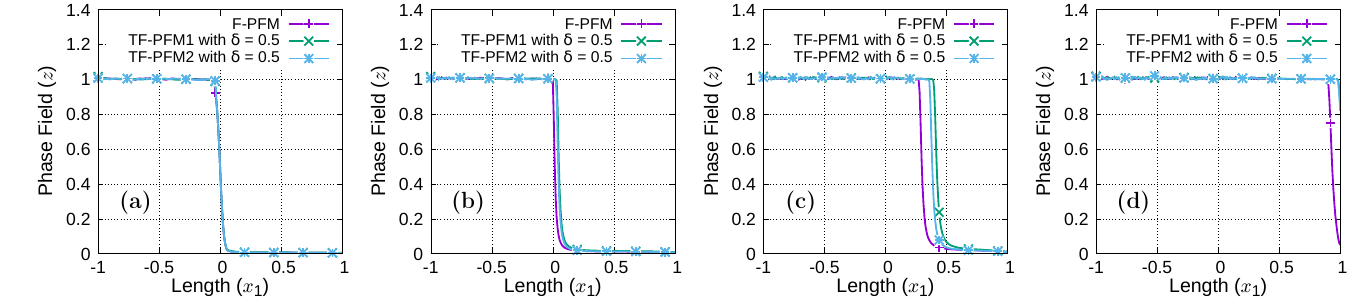
Figure 11. Comparison of the profiles of z obtained by F-PFM, TF-PFM1, and TF-PFM2 along the line